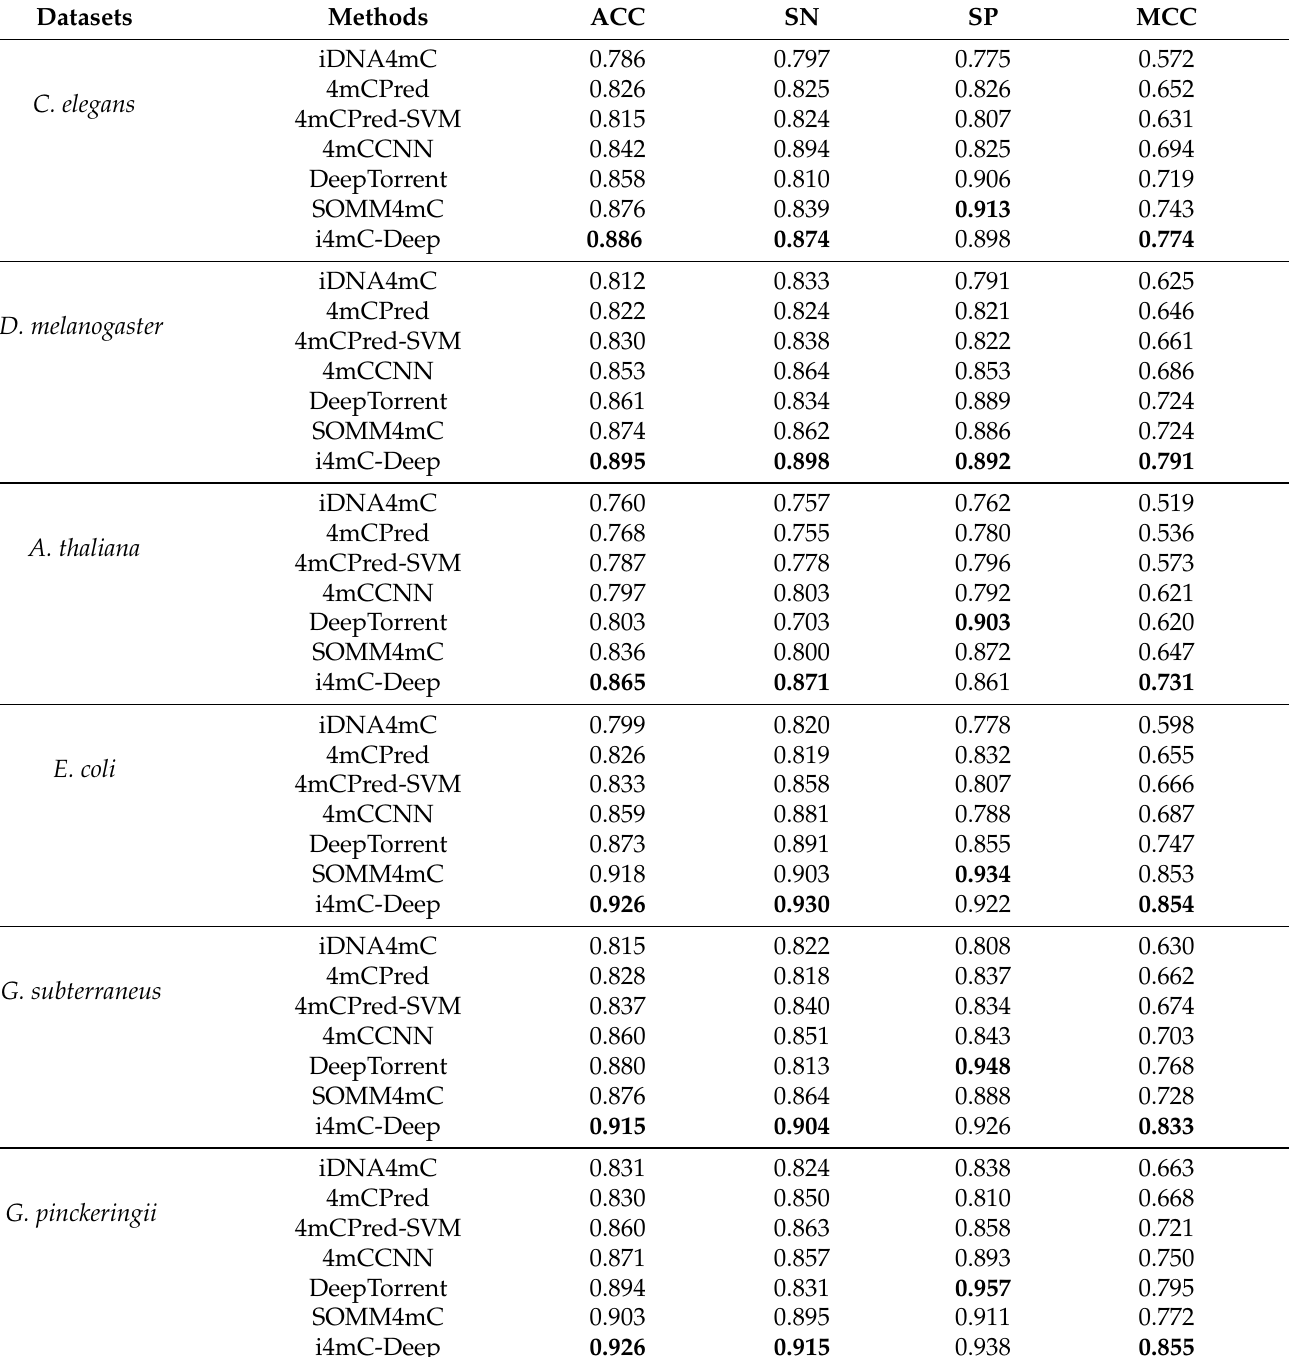
Table 3. The performance comparison between the i4mC-Deep and the existing computational tools for 4mC sites.